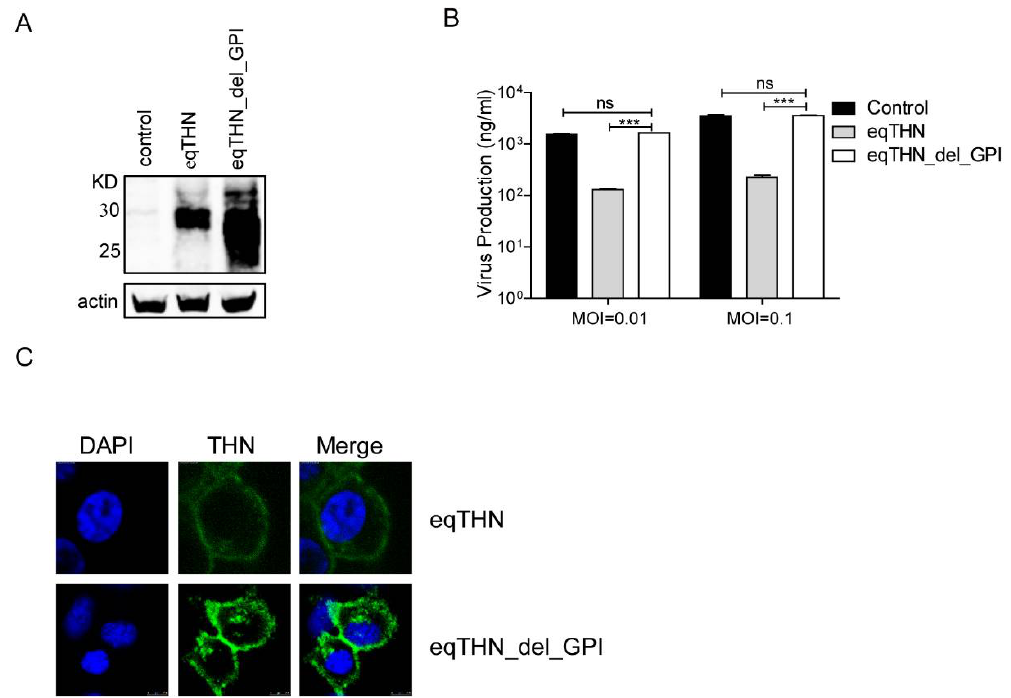
9 of 18 experiments. Error bars indicate standard deviations (SD); ( D ) Stable expression of HA-tagged huTHN_del_14 in MDCK cells. Cells were lysed and the sample was treated as described for panel A in Figure 1; ( E ) The amount of SC09 released from MDCK, huTHN-expressing and huTHN_del_14-expressing MDCK cells at 48 h post infection with SC09 at MOIs of 0.01 and 0.1. Infection and detection were carried out as described as above. The results of a single experiment performed with duplicate samples are shown, and results were subsequently confirmed in three